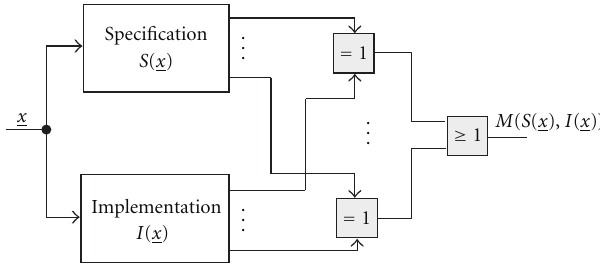
Figure 2: Construction of the miter M ( S ( x ), I ( x